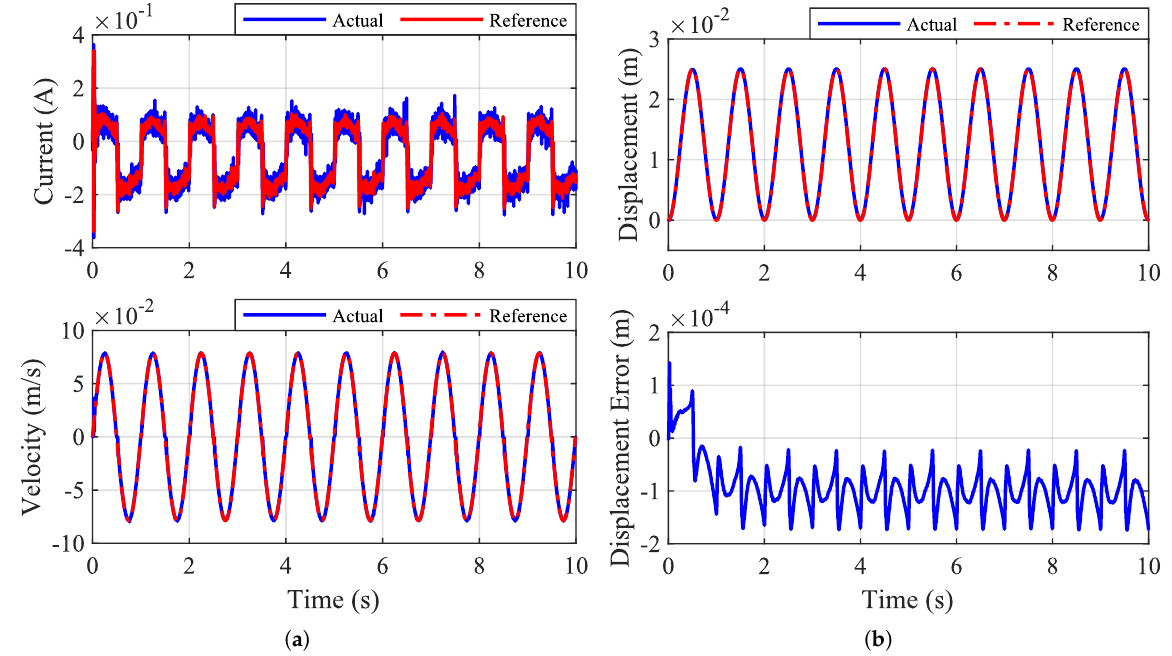
Figure 9. Experimental waveforms for sinusoidal position tracking at 1.0 Hz with α = 5, K v = 20, K p = 40. ( a ) Current and velocity; ( b ) displacement and displacement error.